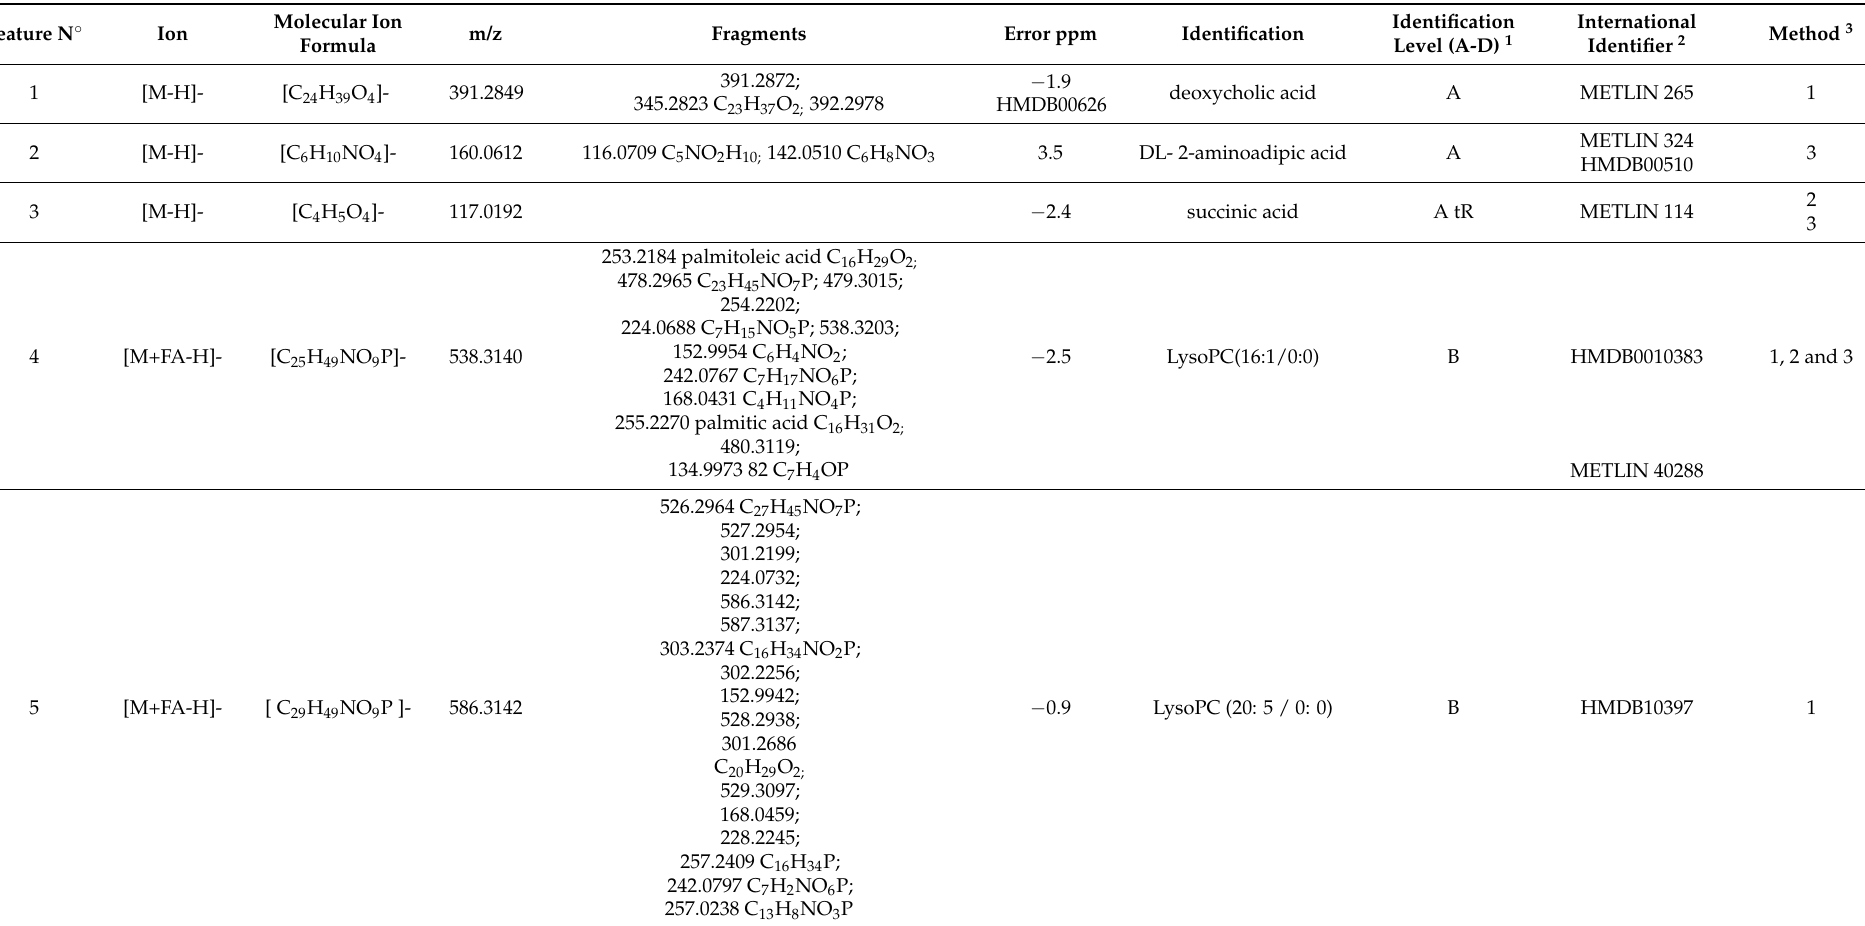
Table 1. Significant metabolites identified by UHPLC-DAD-QTOF which are related with CVD (positive and negative ionization